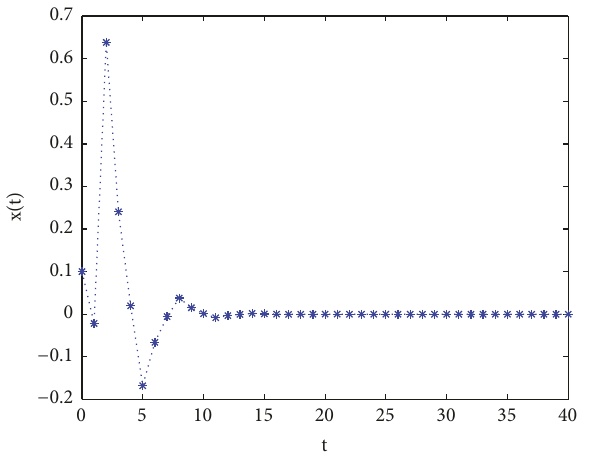
Figure 2: System state response in Example 2. Figure 3: System output response in Example